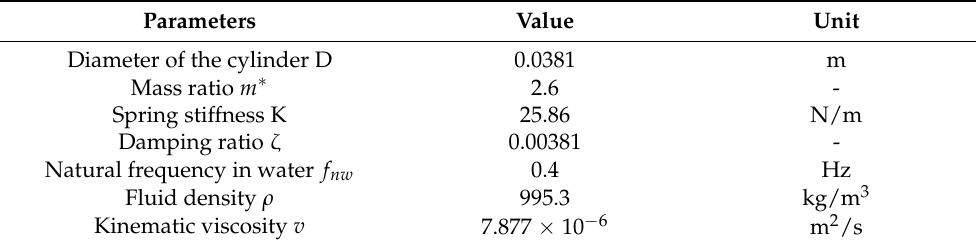
Table 1. The structure and fluid parameters.